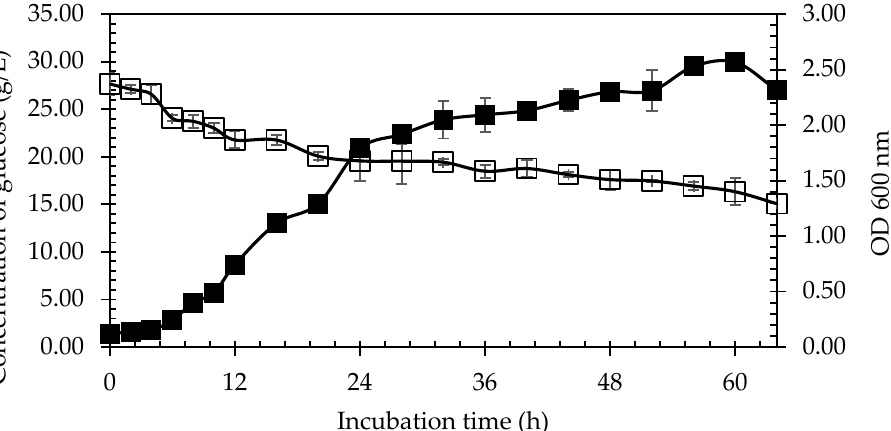
Figure 4. Growth profiling of B. subtilis ATCC 6051 using glucose as carbon source. Symbols represent: □ : glucose; ■ : OD 600 . Error bars indicate the mean value ± standard deviation of triplicates of the sample.